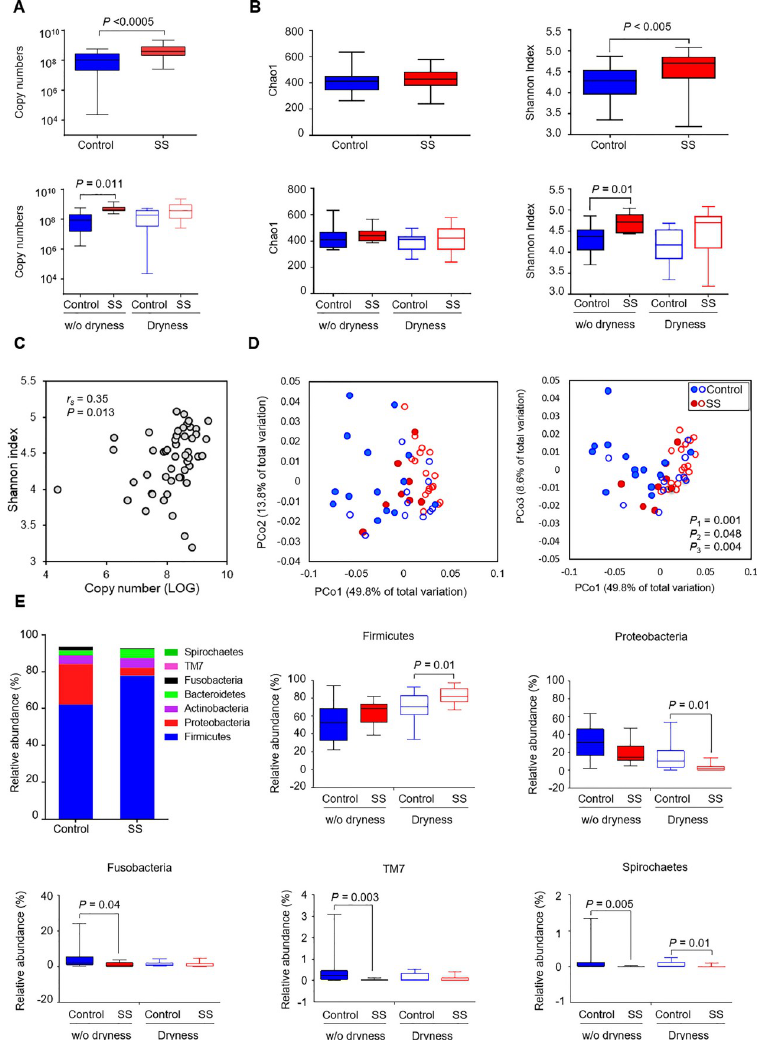
Fig 1. Dysbiosis of oral microbiota in patients with Sjo¨gren syndrome (SS). Oral bacterial communities collected by whole mouthwash from control, including healthy subjects ( n = 15) and drug-induced dry mouth patients ( n = 10), and SS patients ( n = 25) were analyzed by pyrosequencing of the 16S rRNA gene. The control and SS groups were divided into subgroups, control without dryness ( n = 14), control with dryness ( n = 11), SS without dryness ( n = 8), and SS with dryness ( n = 17). (A) The total bacterial load in each sample was estimated by real-time PCR using universal primers targeting the bacterial 16S rRNA gene. The total bacterial load was expressed as the 16S rRNA gene copy number in the total DNA obtained from each sample. (B) Measures of alpha diversity (Chao1 and Shannon indices) are presented. (C) Correlation plot between the total bacterial load and the Shannon index. (D) PCoA plot generated using a weighted UniFrac metric. Empty symbols indicate subjects with dryness. R 2 and P values by PERMANOVA (adonis) test. P 1 : control ( n = 25) vs. SS ( n = 25), P 2 : control without dryness vs. SS without dryness, P 3 : control with dryness vs. SS with dryness. (E) The mean relative abundance levels of the top 7 phyla in control ( n = 25) and SS ( n = 25) are presented as a column graph. � , P < 0.05 by Mann-Whitney U test. For the 5 phyla with significant intergroup differences, the relative abundance of control and SS subgroups, i.e., either without (w/o) dryness or with dryness, are presented as boxplots. P values by Kruskal-Wallis test followed by post hoc analysis with Bonferroni